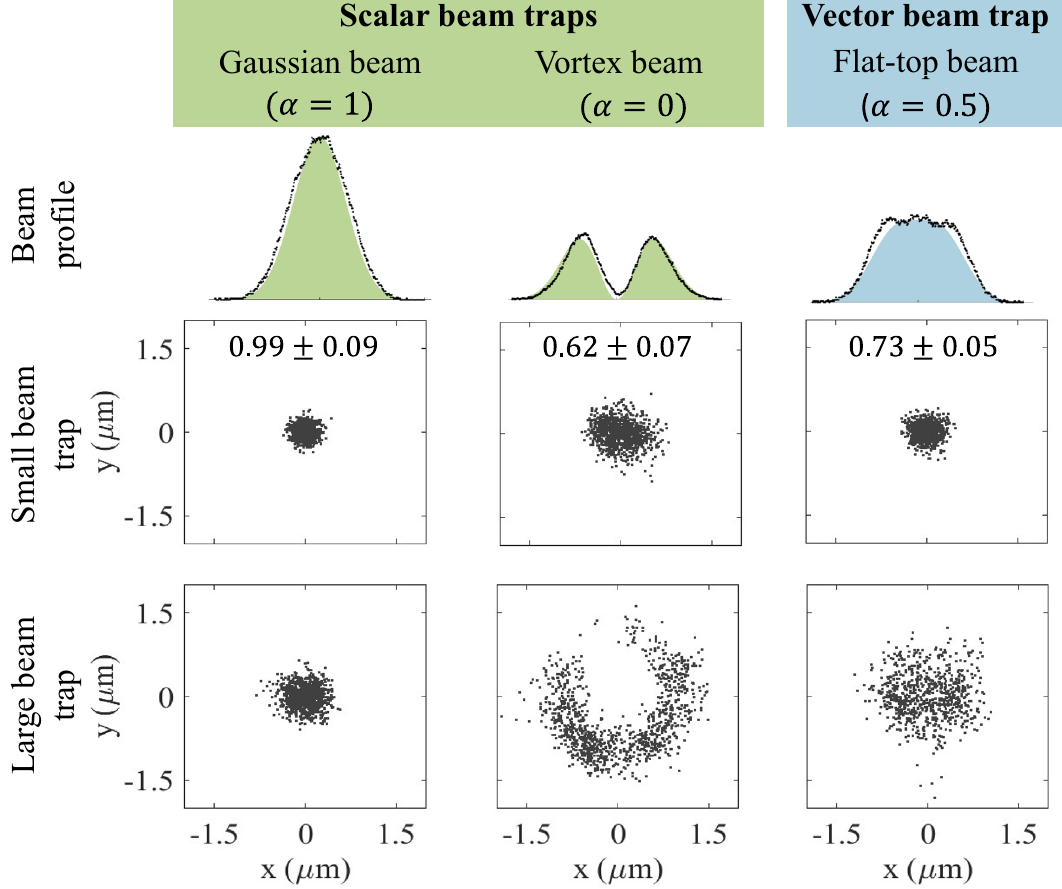
Figure 7. Movement of beads trapped with a Gaussian, vortex and vector flat-top beam when the beam size is smaller than the particle (small beam trap) or larger than the particle (large beam trap). The bead had a 2 µ m diameter, the small trap had a beam diameter of 1.8 µ m and the large trap a diameter of 3.1 µ m . The trap stiffness (± standard deviation) for the small beam traps are reported (unit: pN/ µ m ).